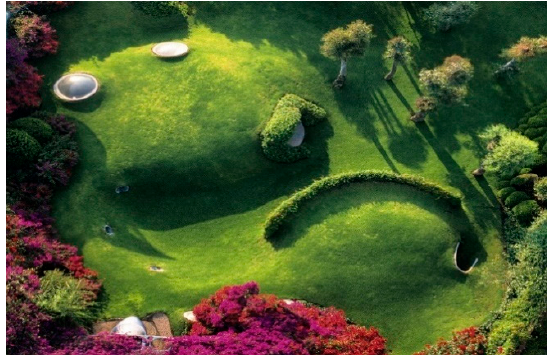
Figure 2. Construction that harmonizes with nature.